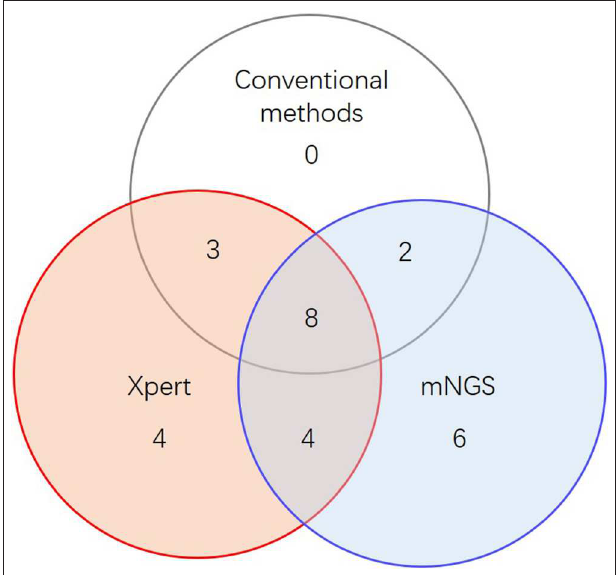
FIGURE 2 | Venn diagram of overlap in active TB